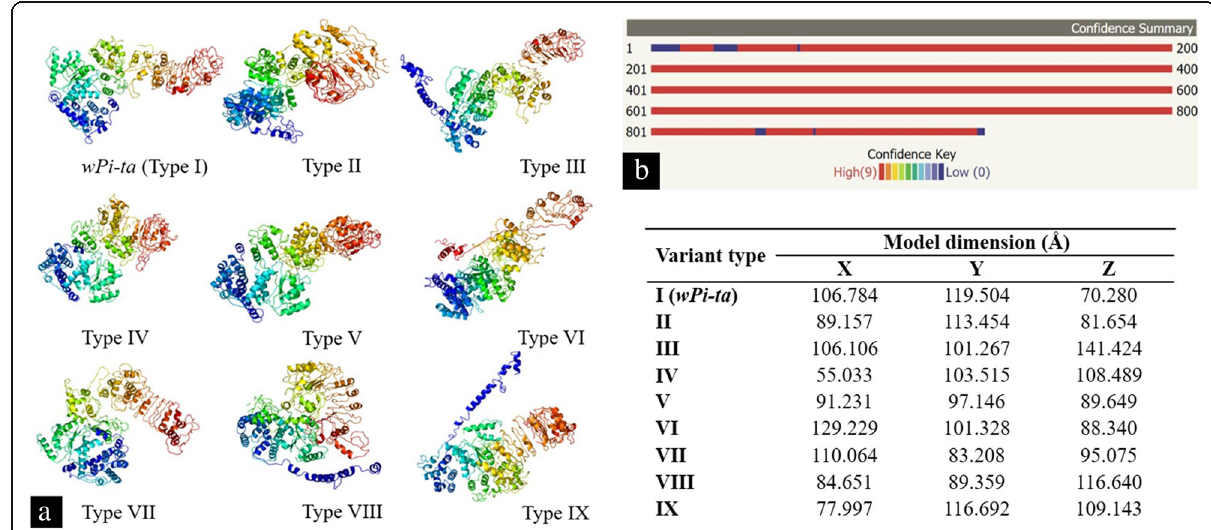
Fig. 1 Details of structure prediction. a Predicted models of Pi-ta protein variants and wPi-ta (Type I) using the Phyre2 server. The images are coloured by rainbow N to C terminus. b Confidence summary of predicted models, and the table has shown the dimension of predicted models of Pi-ta protein variants using three coordinates (X-axis, Y-axis, Z-axis), in Angstrom